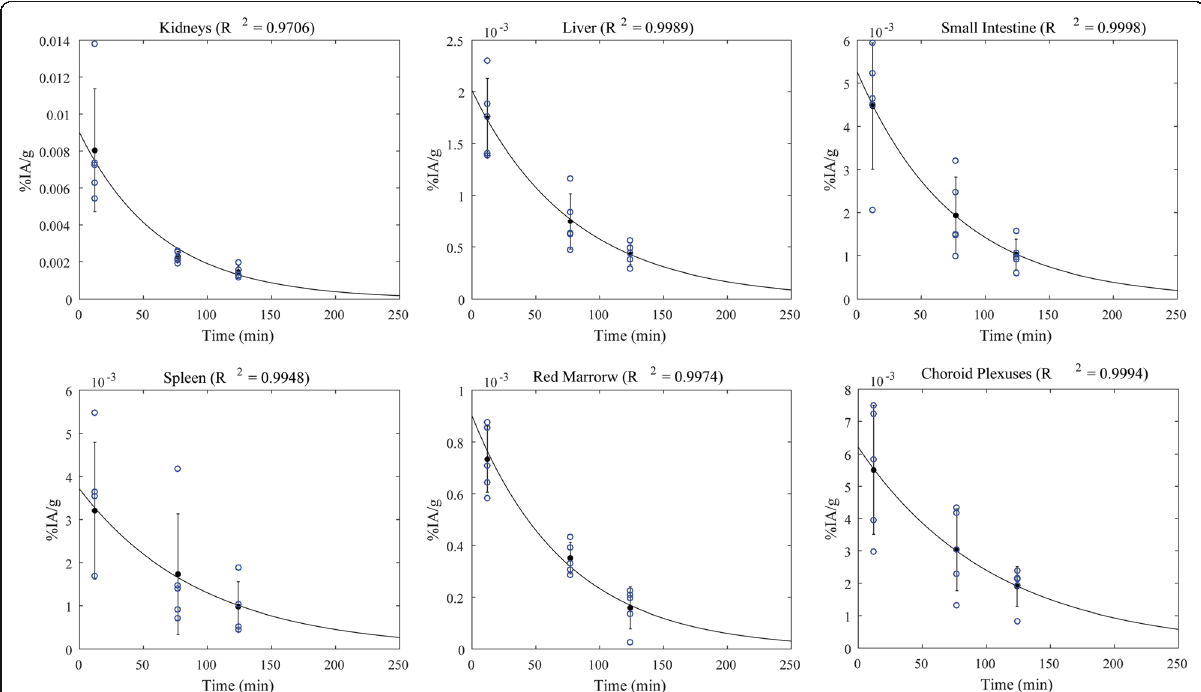
Fig. 3 68 Ga-NODAGA-RGDyK time-activity concentrations for some of the most irradiated organs. The organ activity was normalized to the injected activity and organ mass (%IA/g). Blue circles at each time point indicates the measurements for the five patients enrolled in this study. Solid lines represent the mono-exponential fits and error bars indicate ±SD. The coefficient of determination ( R 2 ) of the fit is reported for each